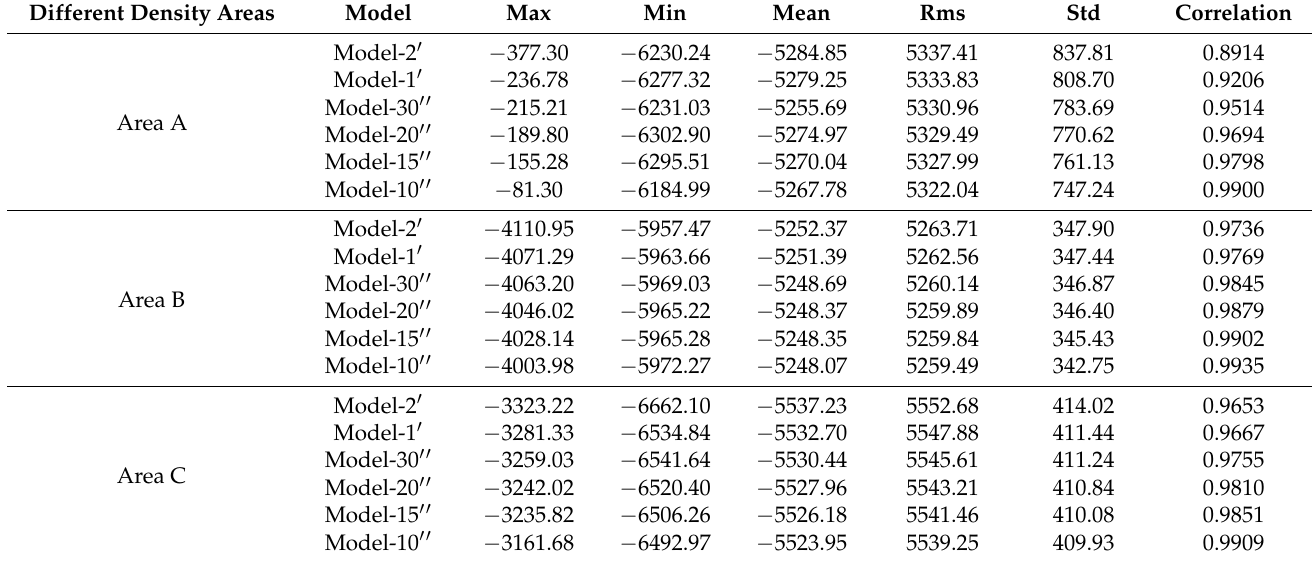
Table 6. Statistics of terrain model data with different resolutions in different density areas